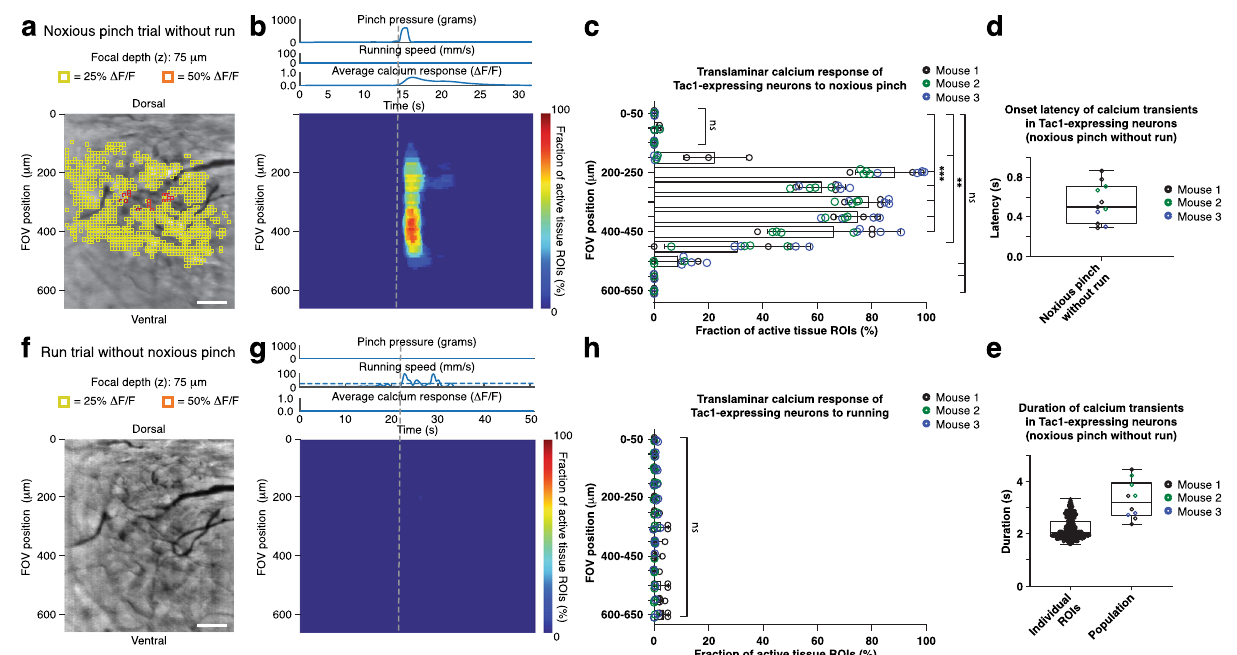
Fig.5|High-speedtranslaminarimagingrevealsnoxiousmechanicalstimulus- evoked activity in the spinal cord of behaving Tac1-GCaMP6f mice. a Average intensityprojectionimagefromaTac1-GCaMP6fmouse(SupplementaryFig.10)at 75 μ m focal depth overlaid with 10 μ m×10 μ m ROIs. Only ROIs with at least 25% (yellow) or 50% Δ F/F (orange) in response to a noxious tail pinch ( p >500g; duration: 1.5s±0.5s) are shown. In this example, the tail pinch did not evoke a locomotorresponse.Scalebar,100 μ m. b Noxioustailpinchevokedactivityacross tissue depth and time for the example recording shown in panel a and Supple- mentary Movie 5. Each row depicts the percent of active ROIs ( ≥ 25% Δ F/F) for a given tissue depth (Methods). The applied pressure stimulus, locomotor activity, and average calcium transient across the FOV are shown above the activity heat map.Theverticaldashedlineindicatespinchonset. c Populationdatashowingthe averagepercentofactiveROIsacrosstissuedepths.Signi fi